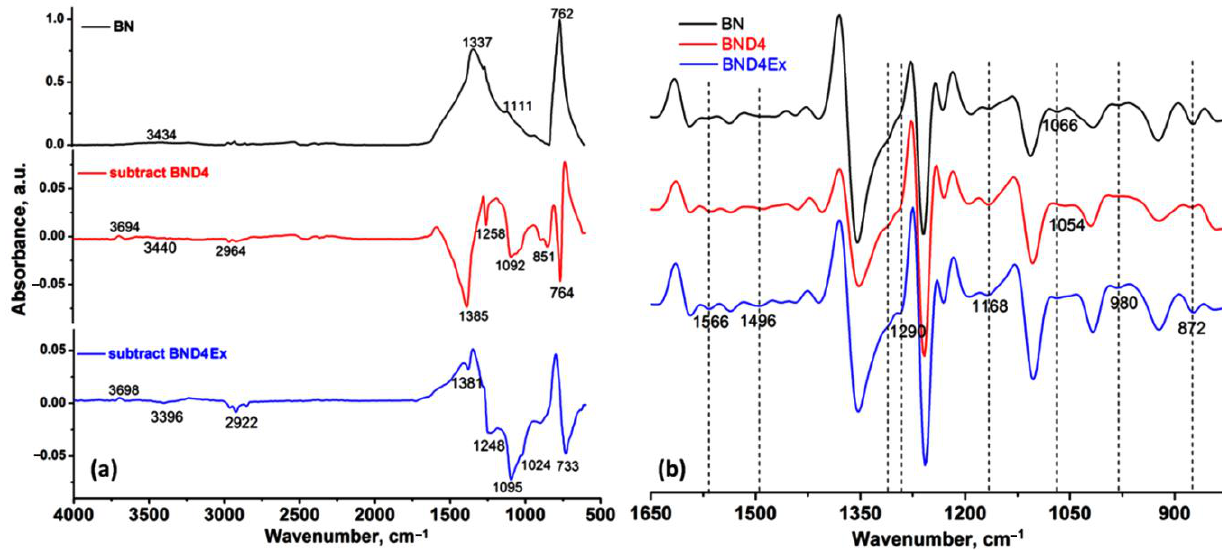
Figure 2. ATR-IR spectrum of BN, subtracted spectra of BND4 and BND4 Ex, ( a ) and the 2nd derivative of the spectra of the sample in the 1650–830 cm − 1 ( b ).